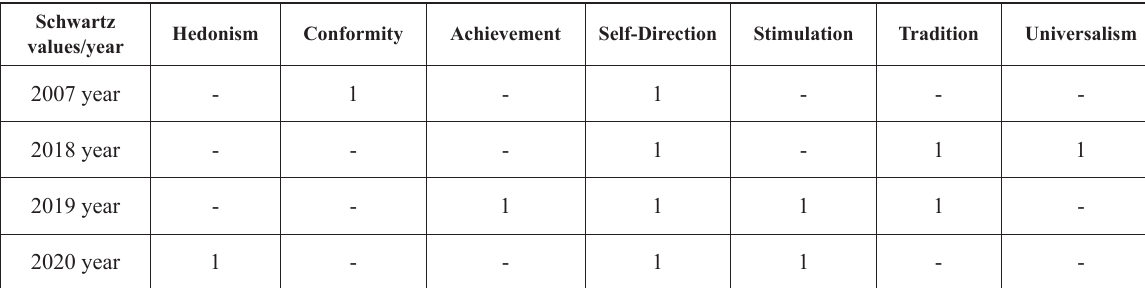
Table 1. Frequency of Schwartz values in slogans Schwartz